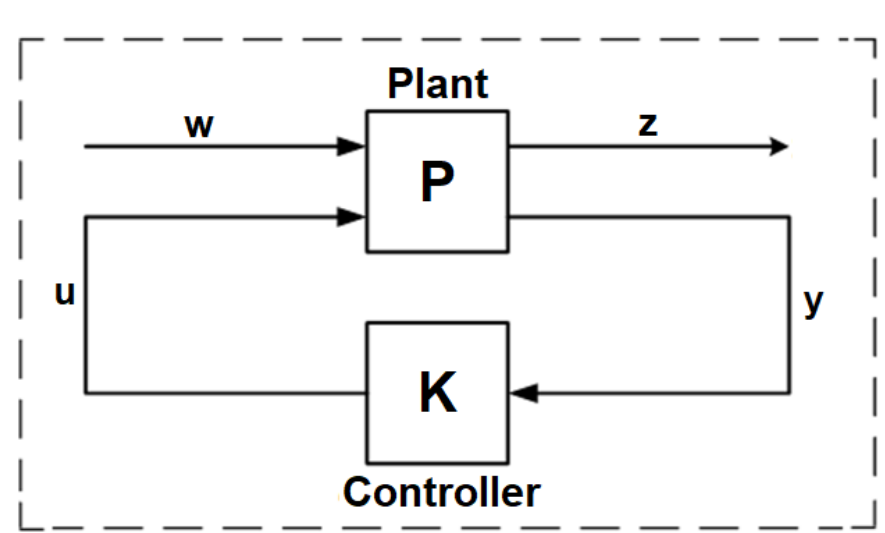
Figure 3. Validation results.